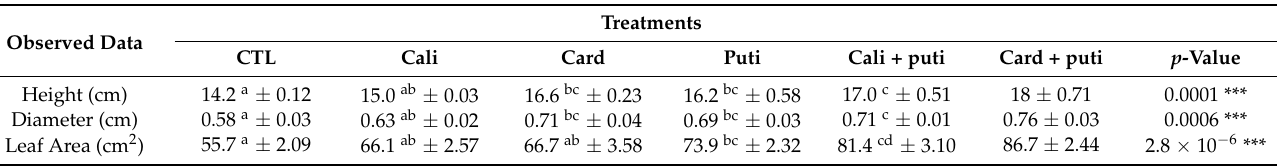
Table 2. Mean value ( ± standard error) of the effect of chitosans produced in combination with P. putida on maize plant growth